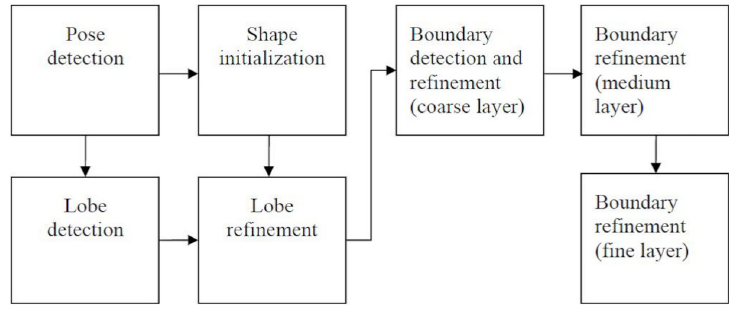
Fig 1. Flowchart and components of the liver segmentation